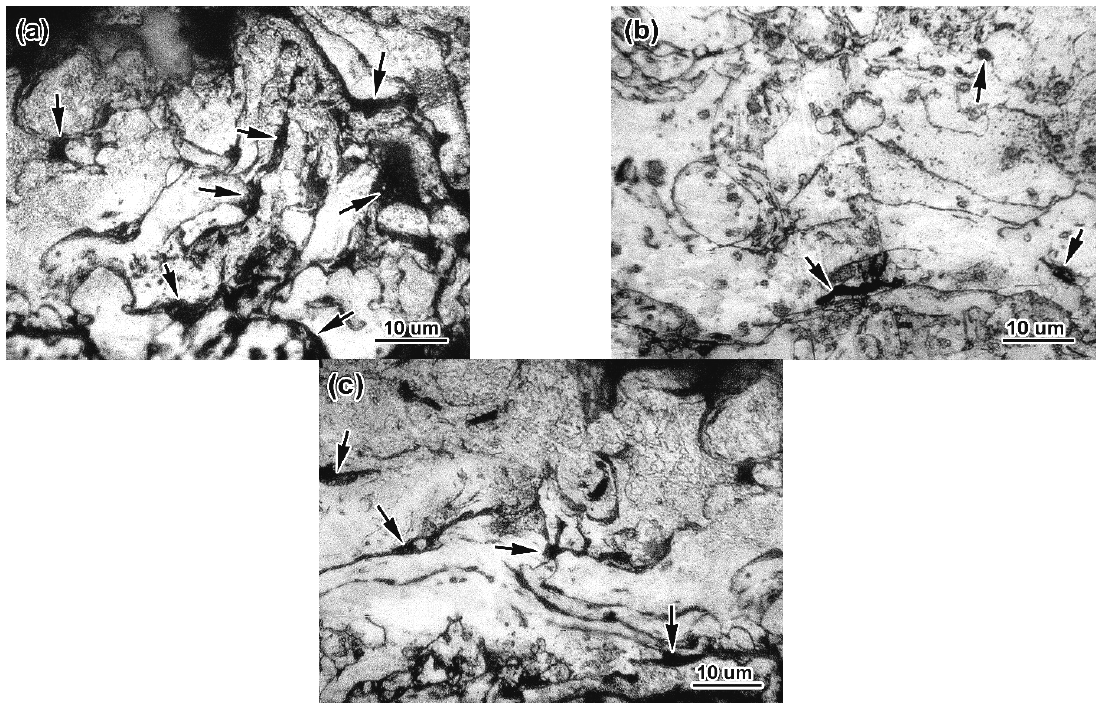
Figure 8. The microstructure of aluminum coating, deposited ( a ) without airflow pulsation and with air pulsation of frequency ( b ) 67 Hz and ( c ) 120 Hz. The oxides are depicted by the arrows.